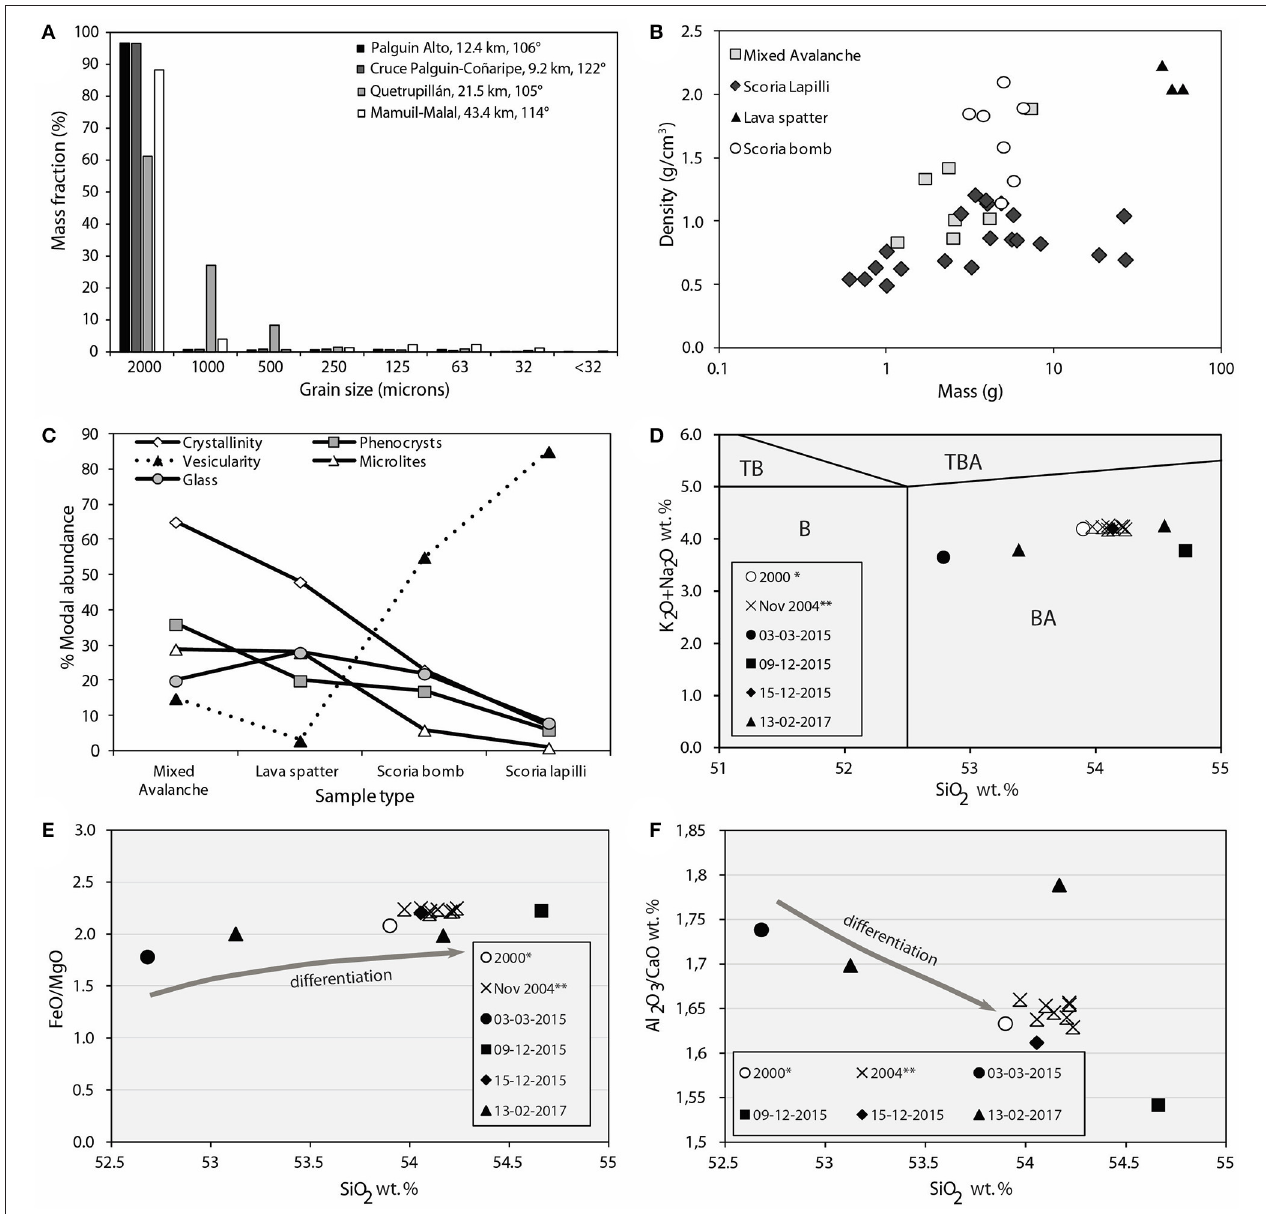
FIGURE 5 | Characteristics of the 2015 tephra fall deposit. (A) Grain size features of selected tephra samples along the dispersal axis of the deposit. (B) Density of the different types of juvenile particles. (C) Total crystallinity and glass of samples. Note that phenocryst and microlite contents are both contained in total crystallinity. (D) SEM-EDS glass major element semi-quantitative geochemistry of four samples collected between 2015 and 2017. *Data from Witter et al. (2004) corresponds to glass composition of year 2,000 pumice fragment. **Data from Gurioli et al. (2008) corresponds to electron microprobe analyses of glass compositions. B, Basalt; BA, Basaltic andesite; TB, Trachybasalt; TBA, Basaltic trachyandesite. (E) FeO/MgO v/s SiO 2 plot of the erupted material between 2015 and 2017. (F) Al 2 O 3 /CaO v/s SiO 2 plot of the erupted material between 2015 and